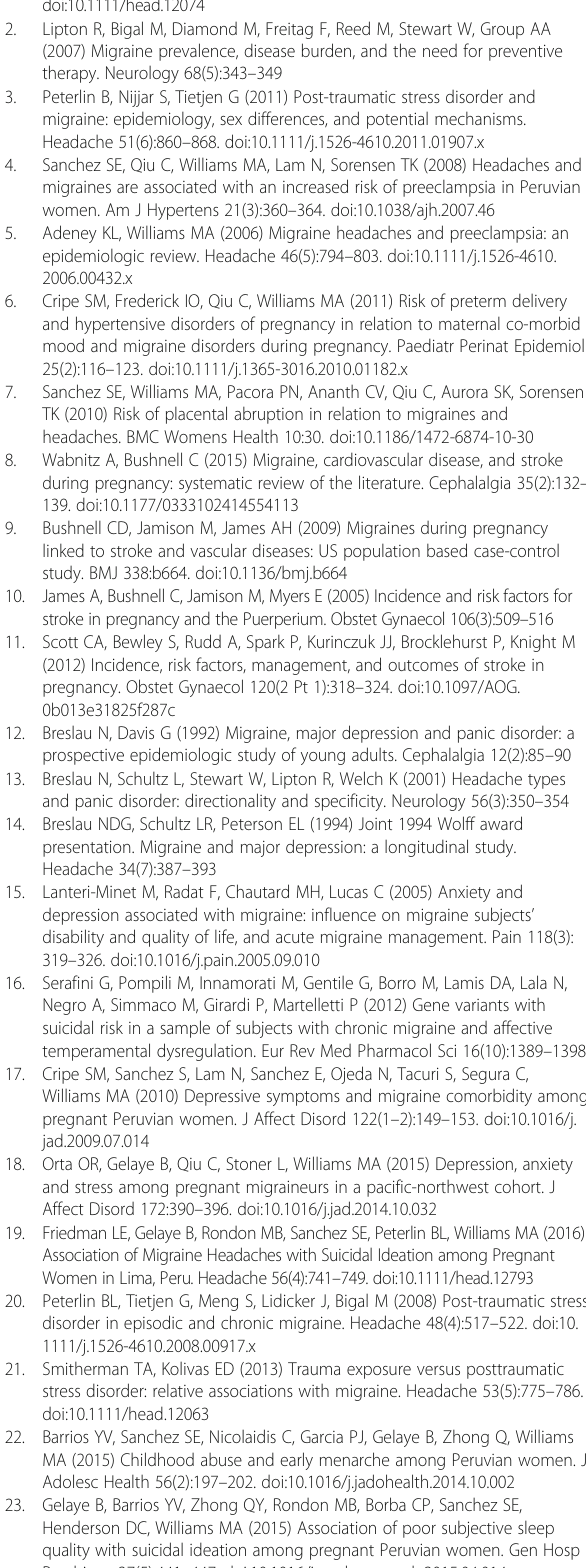
Additional file 1: Table S1. Socio-demographic and reproductive characteristics of the study population according to PTSD a in Lima,